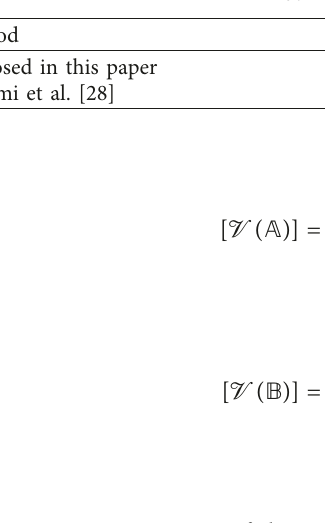
Table 7: Alternative rank comparison using NHSM and NSM